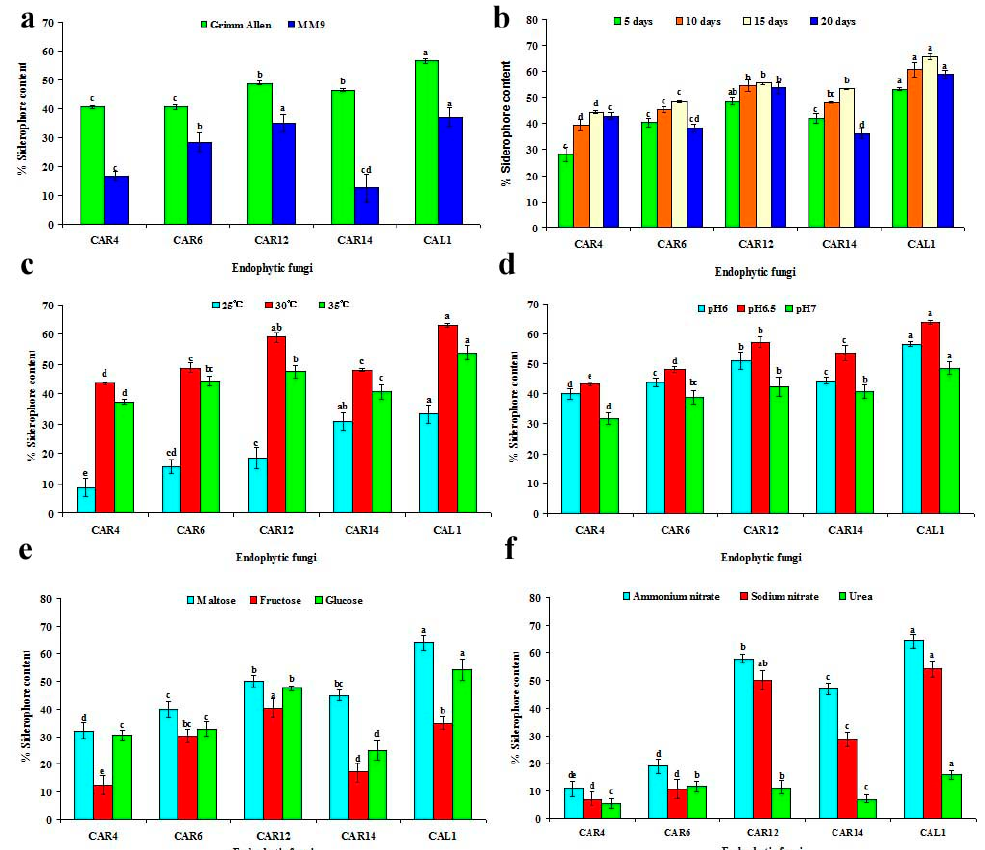
Figure 2. Effect of different culture parameters on siderophore production. ( a ) Effect of media, ( b ) Effect of incubation period, ( c ). Effect of temperature, ( d ) Effect of pH, ( e ) Effect of carbon sources, ( f ) Effect of nitrogen sources. Mean values followed by same letters are not significantly different according to DMRT at p ≤ 0.05.